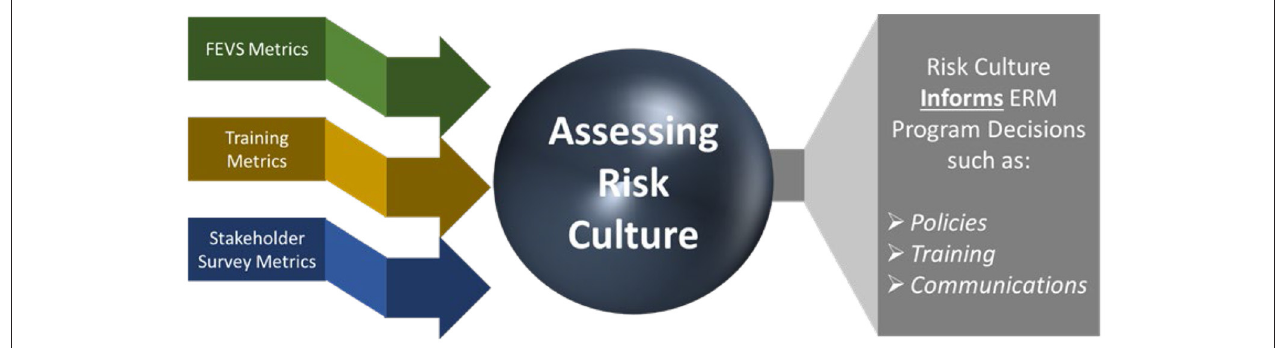
FIGURE 2 | NIH utilizes multiple sources for behavioral metrics to assess risk culture, which informs ERM program decisions. (Graphic created by